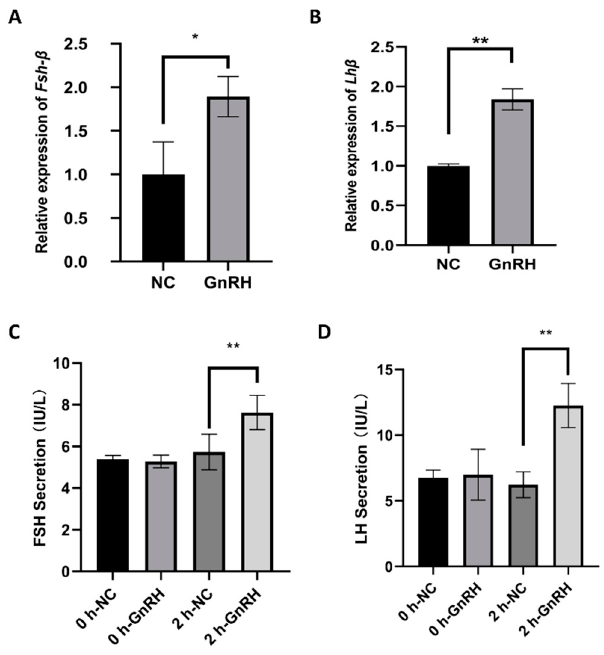
Figure 1. GnRH treatment upregulates the expression of Fsh β and Lh β . After rats were treated with GnRH, Fsh β ( A ) and Lh β ( B ) expression in the anterior pituitary was detected by RT-qPCR, and FSH and LH secretion was detected by ELISA ( C , D ). The data are shown as the mean ± SD of at least three independent experiments. Statistical significance was analyzed by one-way ANOVA (* p < 0.05; ** p < 0.01).